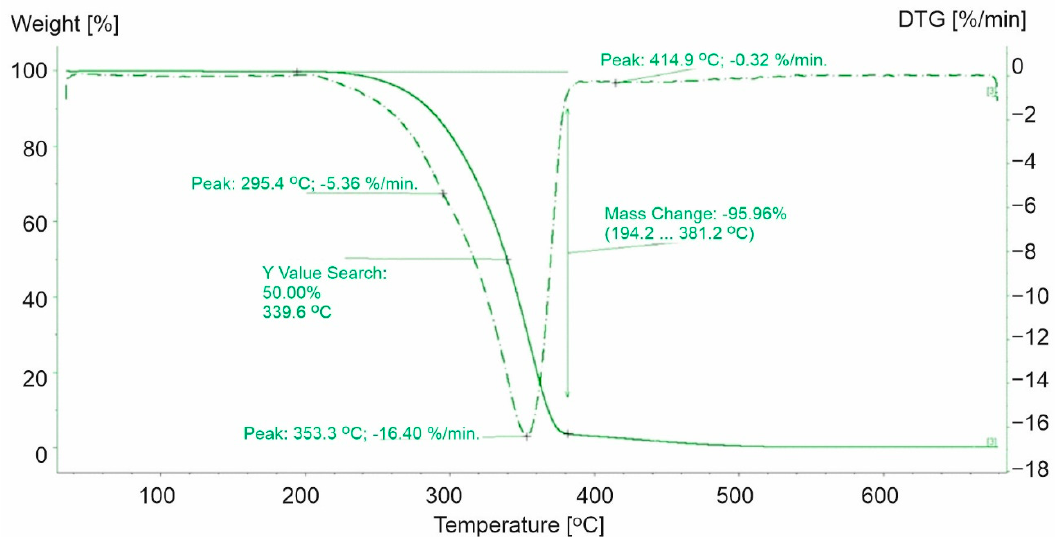
Figure 3. TG and DTG curves for PP ‐ 3. The green line presents TG curve, while the green dot line presents DTG curve.